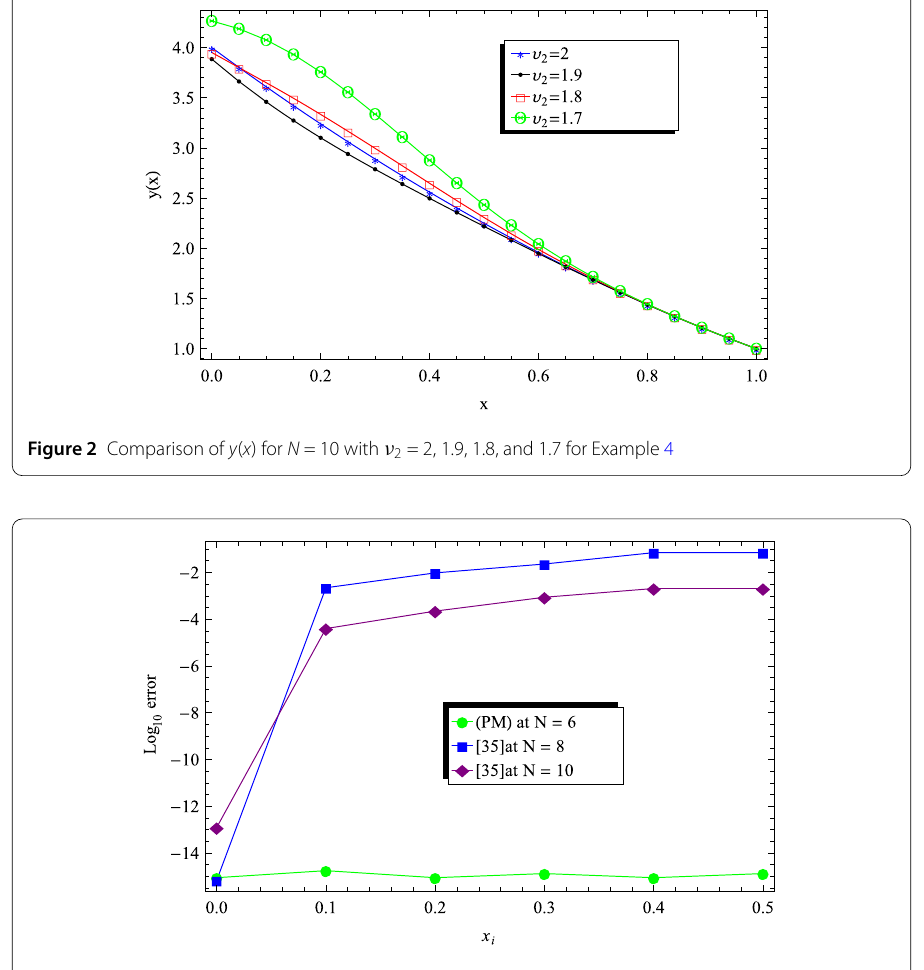
Figure 3 Comparison of error function for the present method at N = 4 and [65] at N = 8 and 10 for Example